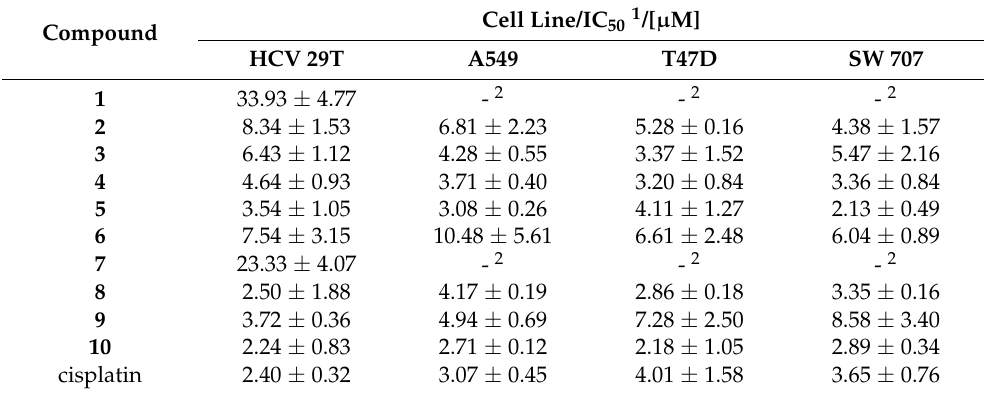
Table 3. Antiproliferative activity of compounds 1 – 10 against human cancer cell lines.